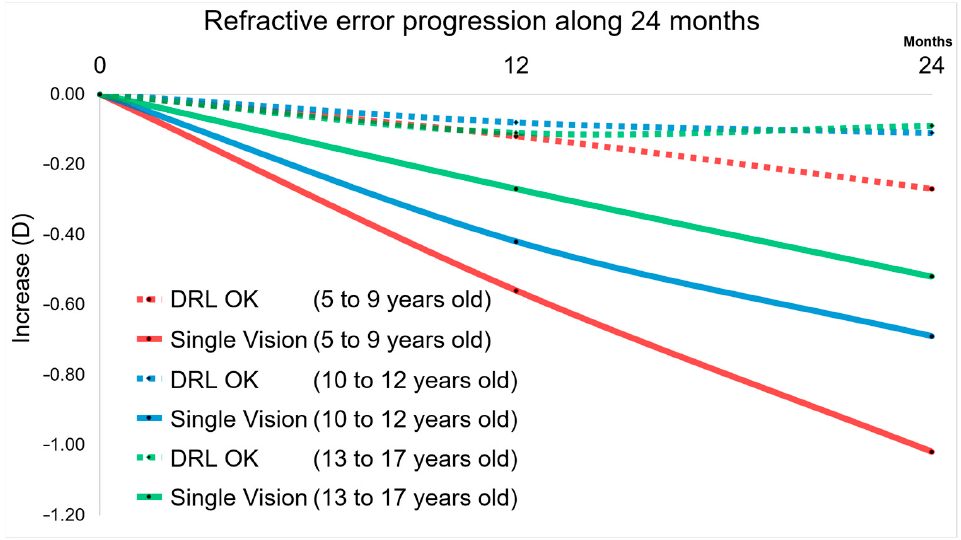
Figure 3. Plot with the M component for all groups over 24 months. DRL and Single Vision Glasses for 5–9, 10–12, and 13–17 years old. Ratios of Refractive error changes are evident for SVG and a sign of slowing is appreciated for higher age groups, showing that myopia is not stopped at the age of 17